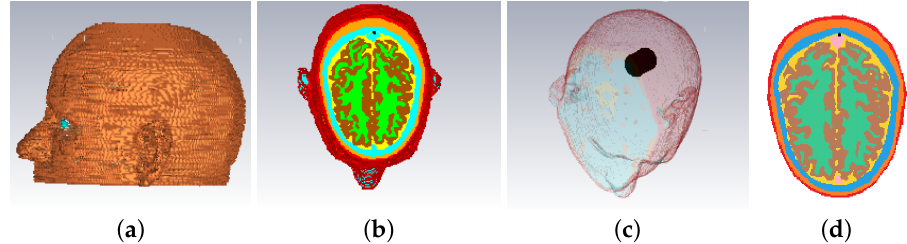
Figure 2. Views of the Zubal phantom in CST: ( a ) 3-D side-view, ( b ) cross-sectional top-down view, ( c ) 3-D view with blood target inserted, ( d ) cross-sectional slice used in the 2-D experiments (93th slice of the original model, where the center of the target is placed). These phantoms are used for the “Case I” imaging scenario described in Section